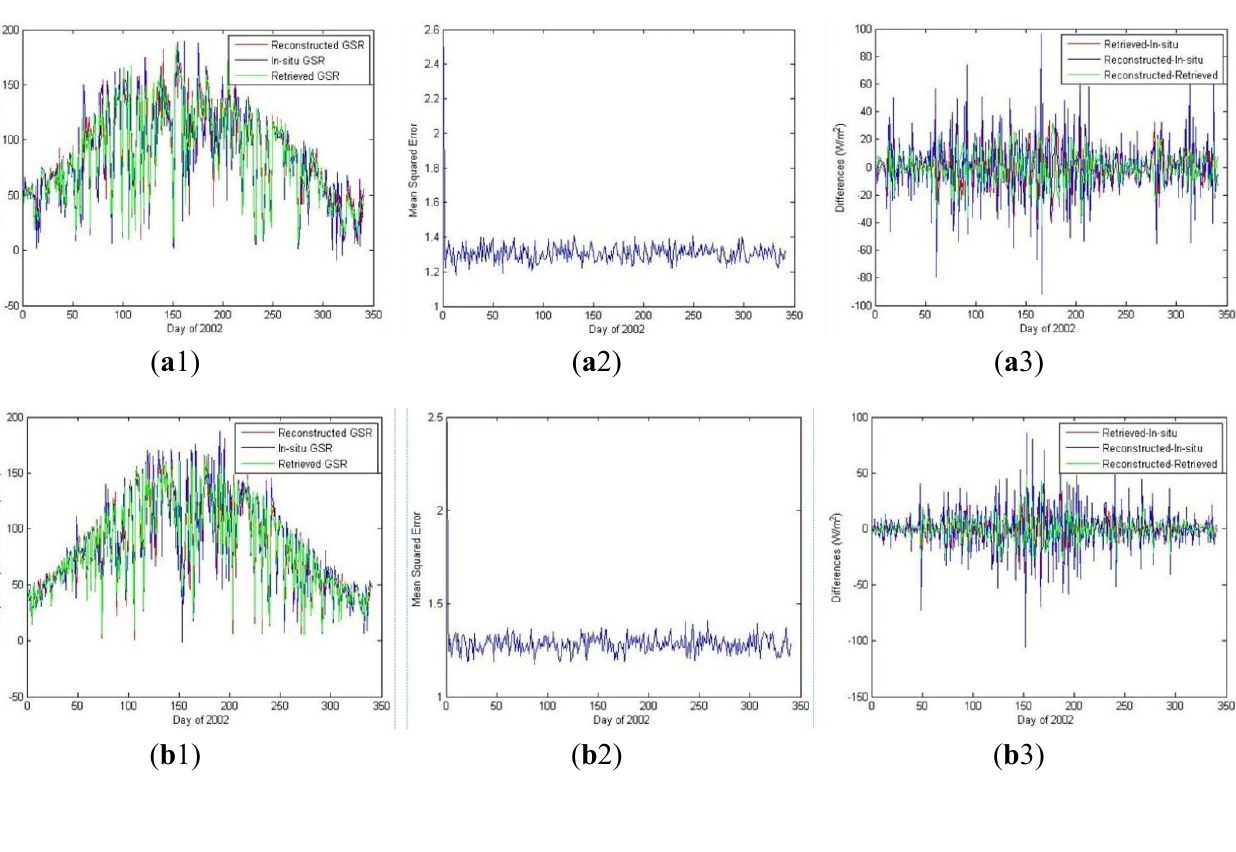
Figure 3. Reconstructed GSR, in situ GSR, retrieved GSR, differences and the MSE of the three datasets at ( a ) Taiyuan; ( b ) Chaoyang; ( c ) Xi’an; ( d ) Jinan; and ( e ) Shenyang meteorological stations in